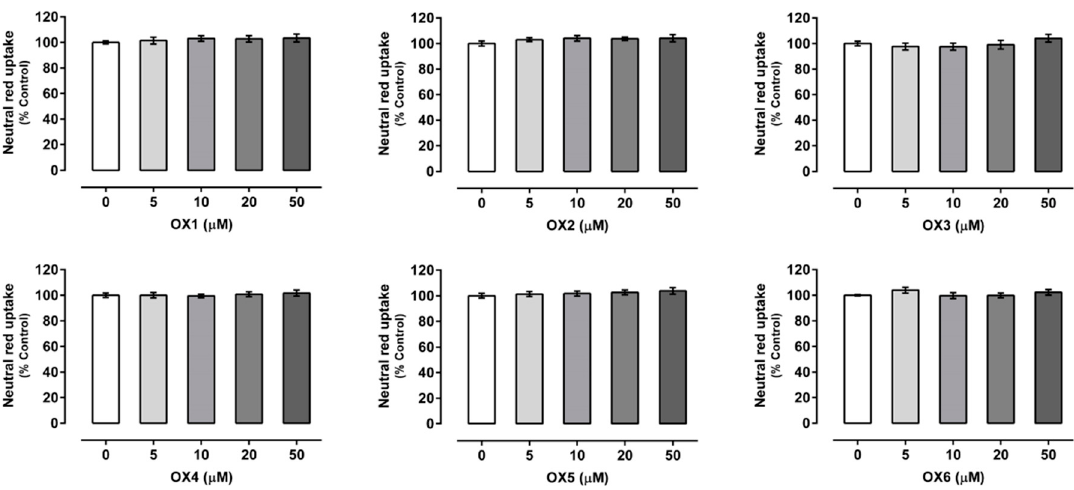
Figure 2. Oxygenated xanthones (OX 1–6, 0–50.0 μ M) cytotoxicity in Caco-2 cells evaluated by the neutral red (NR) uptake assay, 24 h after incubation. Results are presented as mean ± SEM from four